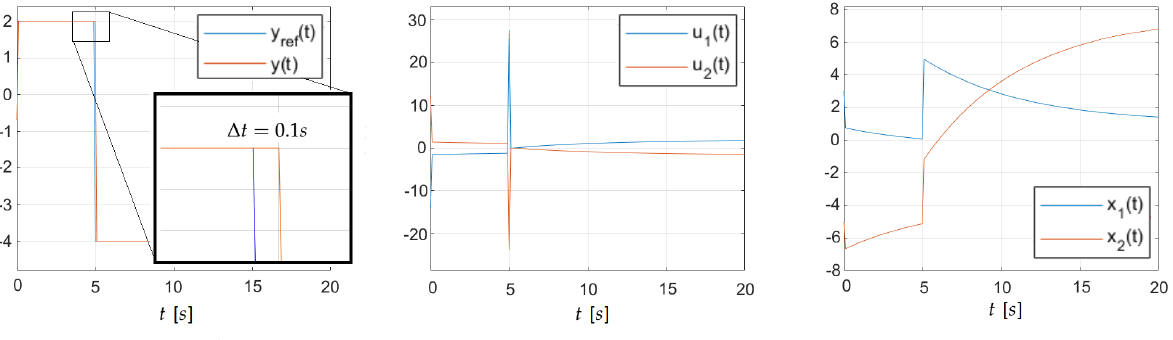
Figure 1. Perfect control plots: T -inverse, case ∆ t = 0.1